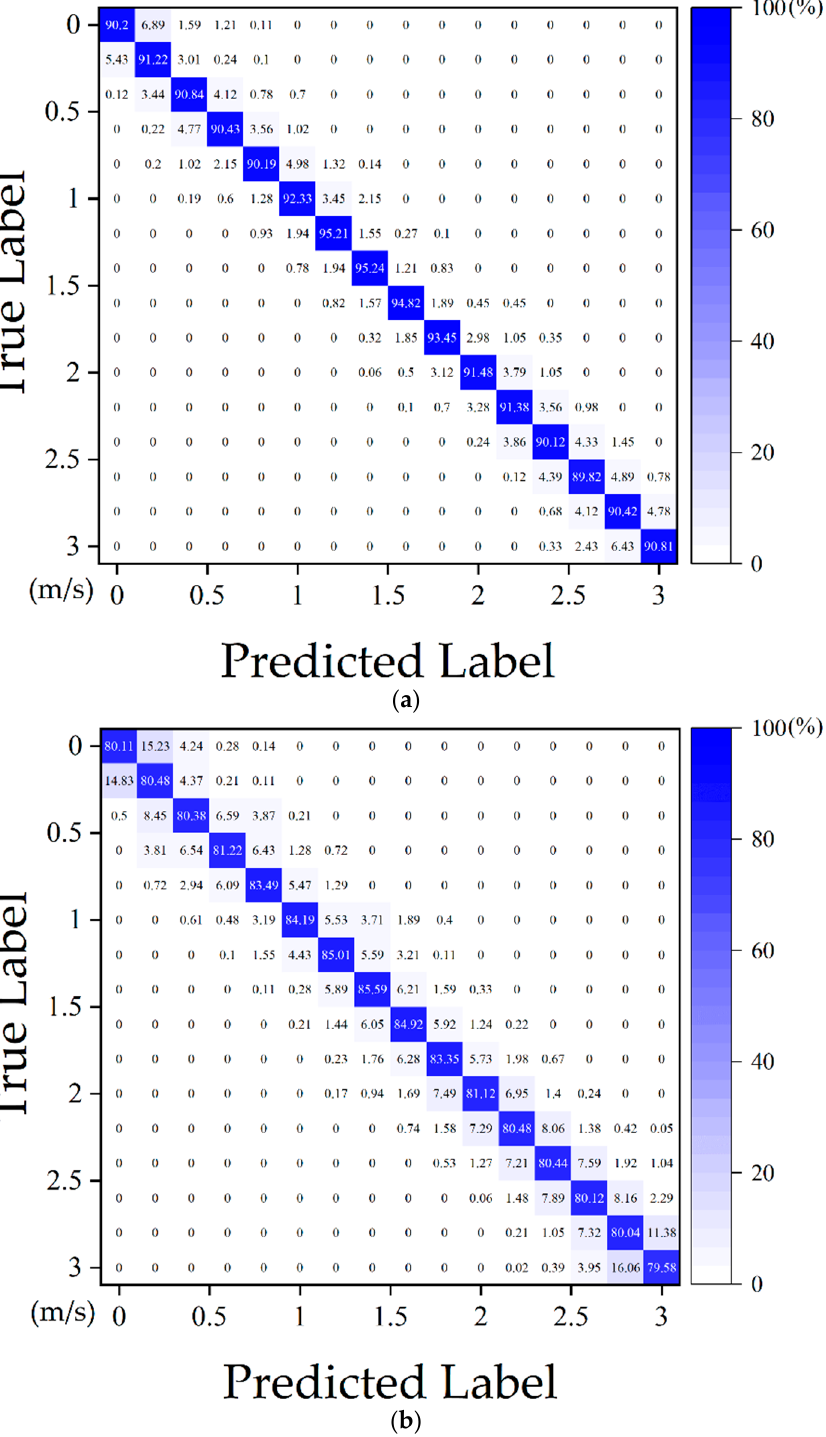
Figure 6. Pedestrian speed estimations for each deep learning model: ( a ) pretrained model results and ( b ) transfer learning model results.